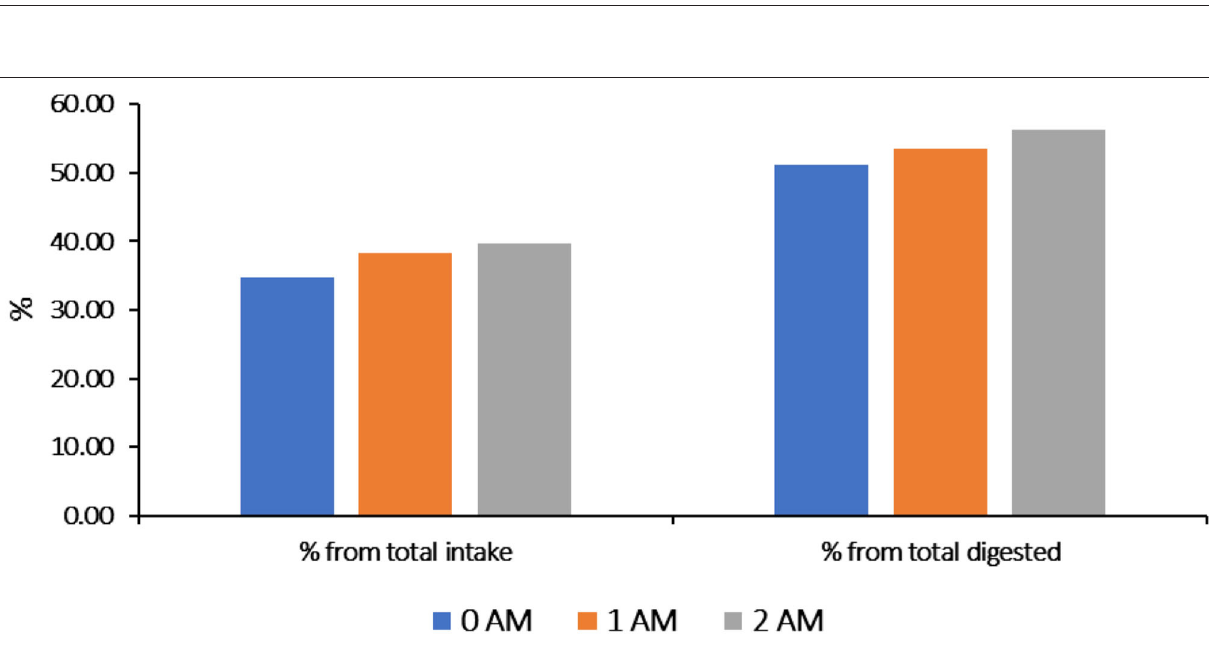
FIGURE 3 | Nitrogen retention in the body of lactating cows (%). 0AM group: received the normal basal ration (Control group); 1AM group: received normal basal ration replacing sunflower cake with 300g of protein concentrate Agro-Matic until parturition and after parturition they received normal basal ration replacing sunflower cake with 1kg of protein concentrate Agro-Matic until the end of lactation period. 2AM group: received normal basal ration replacing Sunflower cake with 500g of protein concentrate Agro-Matic until parturition and after parturition they received normal basal ration replacing Sunflower cake with 1.5kg of protein concentrate Agro-Matic until the end of the lactation